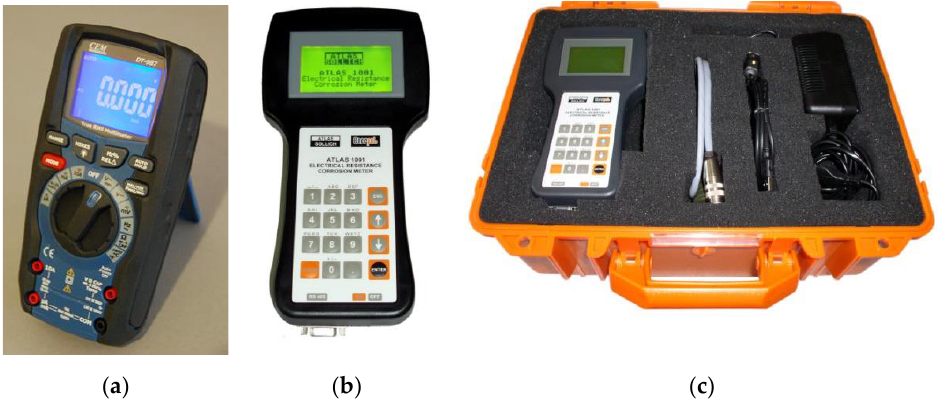
Figure 11. Meters fitted in the protection system: ( a ) multimeter for potential measurements, ( b , c ) ATLAS 1001 COR resistive corrosion meter with accessories.